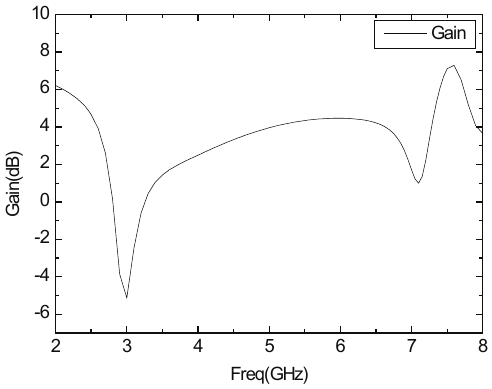
Figure 12. The gain curve of the antenna.